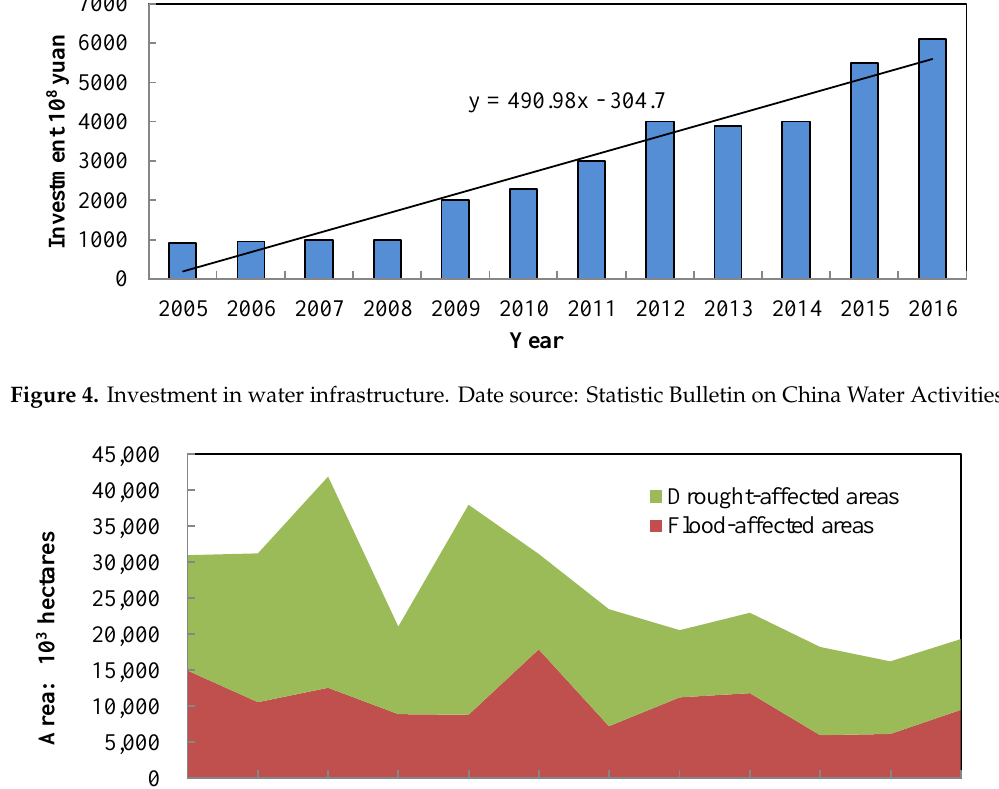
y = 490.98x - 304.7